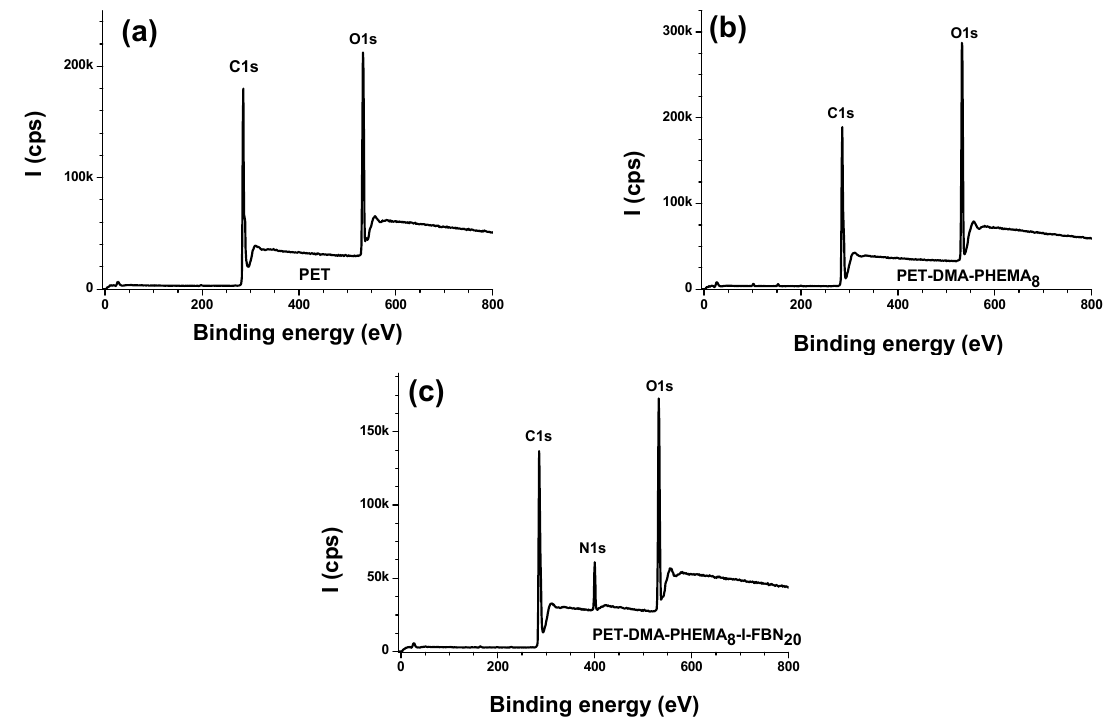
Figure 2. Survey regions of bare and modified PET. ( a ) PET, ( b ) PET-DMA-PHEMA 8 , ( c ) PET-DMA-PHEMA 8 -I-FBN 20 .